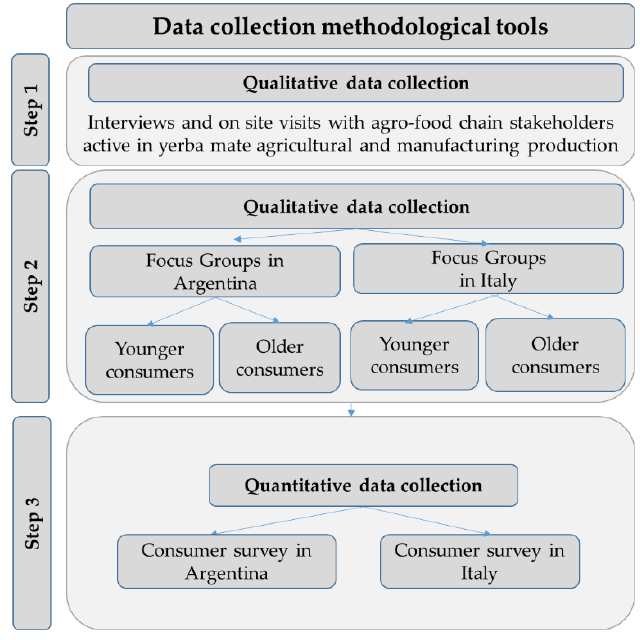
Figure 5. S teps of primary data collection phase. Figure 5. Steps of primary data collection